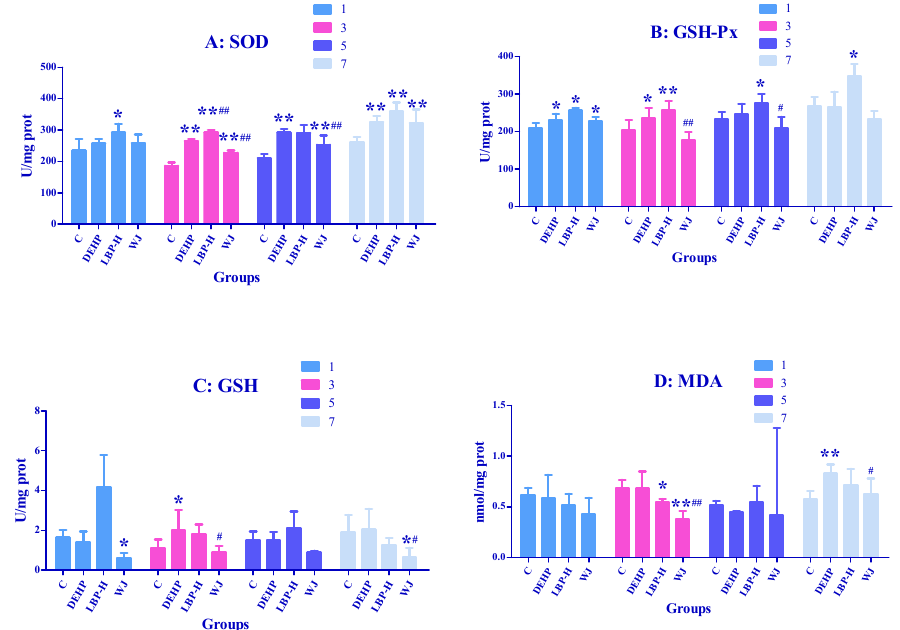
Figure 5. Effects of LBP and WJ intervention on liver oxidative stress index in rats exposed to DEHP ( n = 5). After one day of DEHP feeding, LBP and WJ were used for continuous intervention, and the liver oxidative stress indexes (SOD, SGH-Px, GSH, MDA) were measured by ELISA kit on the first, third, fifth, and seventh day of intervention. ( A – D ): concentrations and activities of SOD, GSH-Px, GSH, and MDA in liver, respectively. Note: data are expressed by mean ± S.D. The significance of differences among treatment groups was determined by one-way ANOVA. * or **: compared with the control group, p < 0.05 or 0.01; # or ## : compared with DEHP group, p < 0.05 or 0.01.